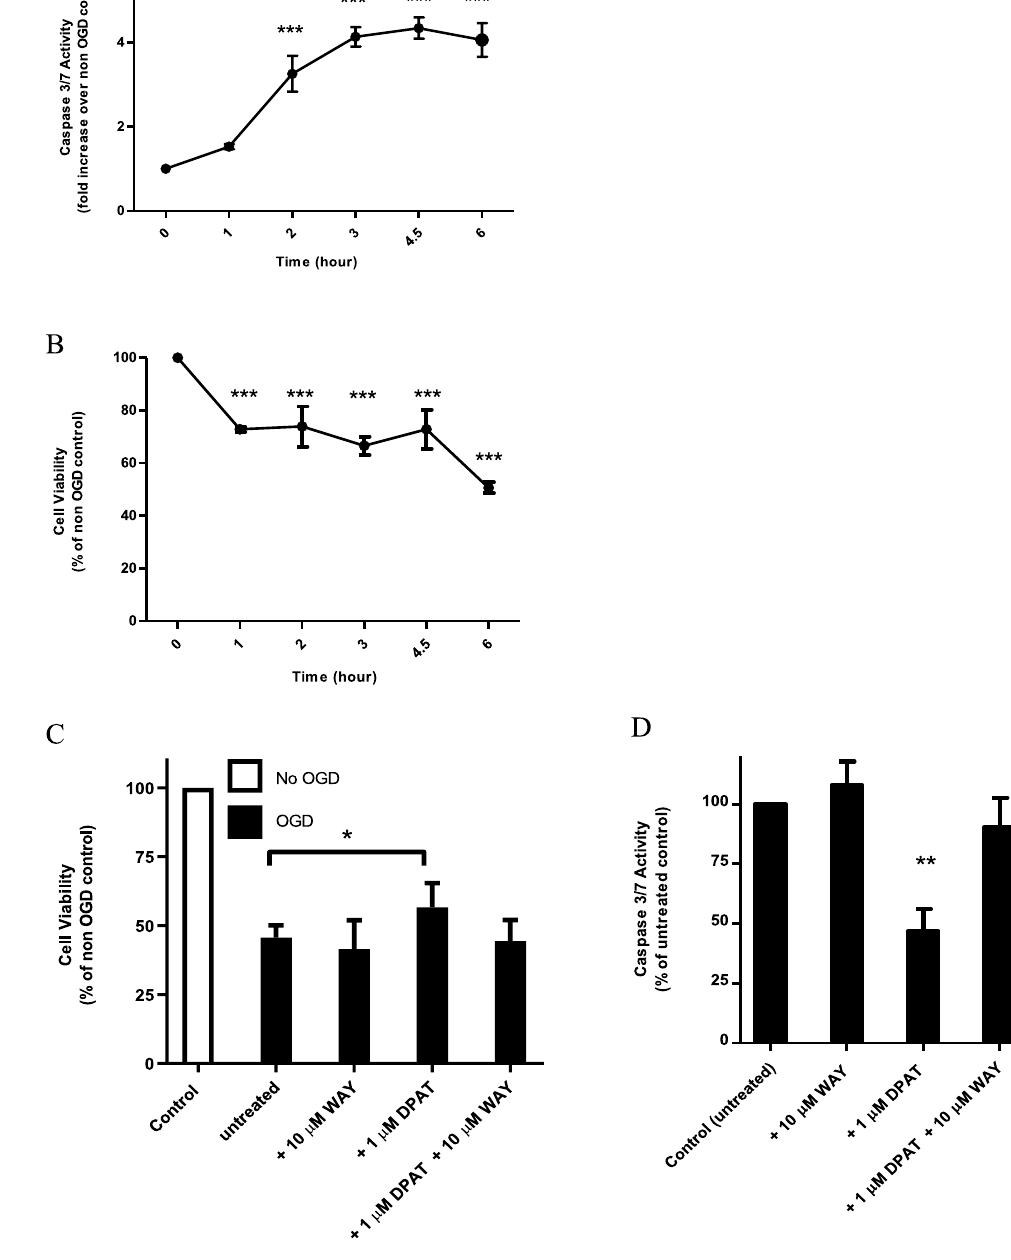
Figure 4. Optimisation and validation of PC12 NS-1 in vitro stroke model. ( A ) NGF-differentiated NS-1 cells were subjected to OGD as described under “Oxygen glucose deprivation”. Caspase 3/7 activity was measured at the indicated durations of OGD and data normalised as fold increase over cells without OGD. Data shown is mean ± SEM from 3 independent experiments of triplicate determination. Statistical testing was performed with one-way ANOVA with Dunnett’s post hoc test. ***p < 0.001 compared to non-OGD control ( B ) NS-1 cells differentiated with NGF were subjected to OGD as described under “Oxygen glucose deprivation” for the indicated durations. Cell viability was then assessed using the MTT assay and data normalised to control cells without OGD. Data are mean ± SEM of 3 independent experiments carried out in triplicate. ***p < 0.001 compared to non-OGD control. Differentiated NS-1 cells were subjected to 3 h OGD then 24 h of normal culture conditions added with WAY100635 or 8-OH-DPAT (or both) as described under “Drug treatment”. Subsequently, cell viability or apoptosis was measured. ( C ) Cell viability was determined with MTT assay. *p < 0.05 compared to non-OGD control. ( D ) Caspase 3/7 activity was measured. Non-OGD baseline activity was removed and data normalised to untreated cells. **p < 0.01 compared to untreated control. All data are expressed as mean ± SEM of 3 experiments determined in